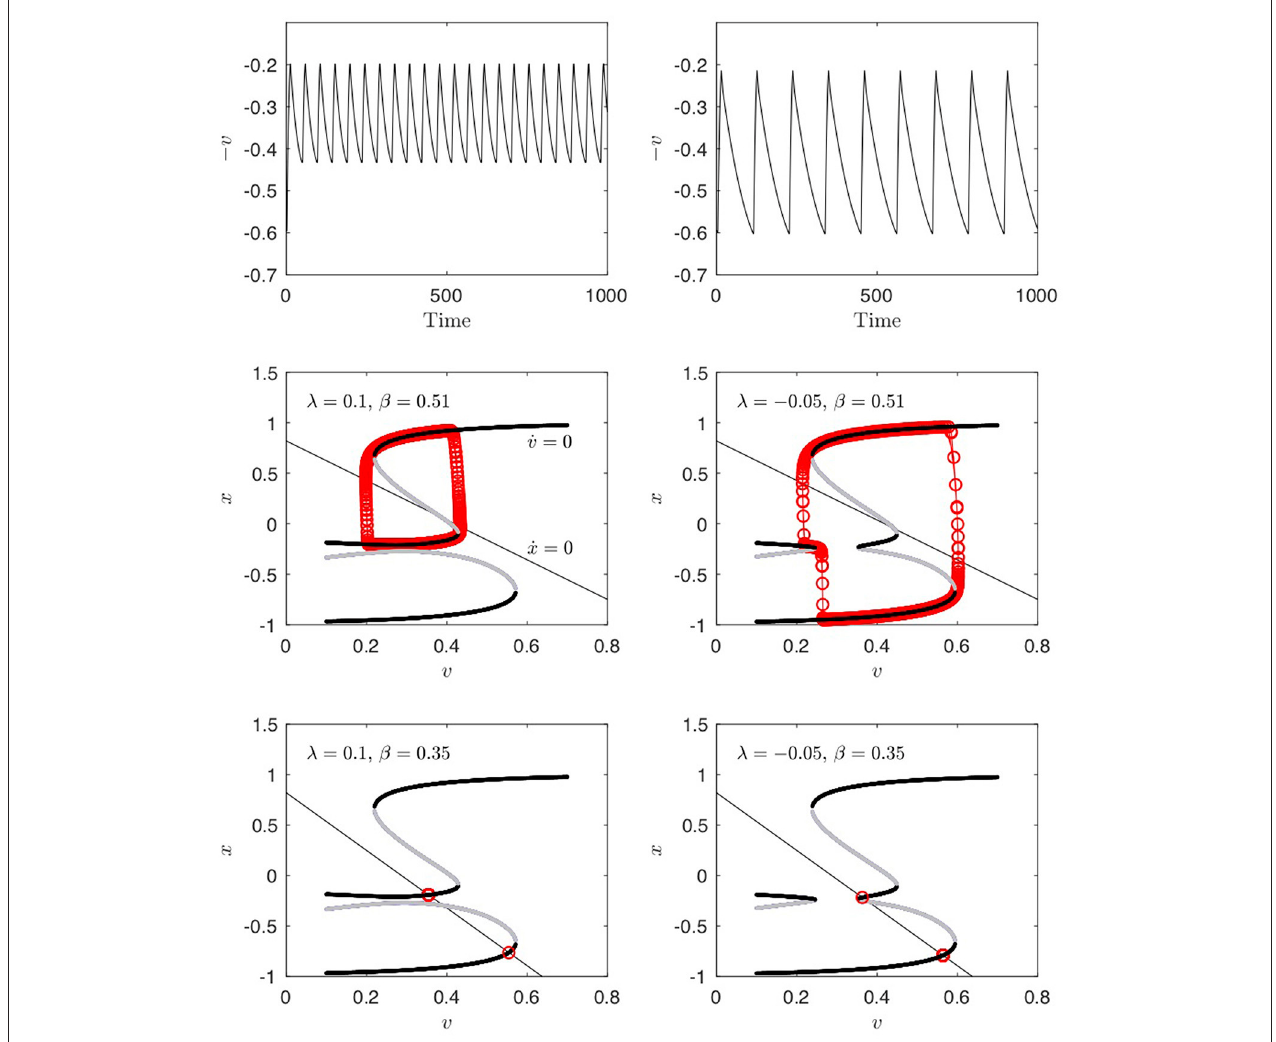
FIGURE 14 | In the autonomous case of no external forcing ( I ( t ) = 0, λ = constant), the system (7) shows internal oscillations both before ( λ > 0) and after ( λ < 0) the transcritical bifurcation at MPT . The period of the internal oscillation is longer than the period of the forcing (41 kyr): Right top panel shows an internal oscillation of 46 kyr for λ = 0.01, while the left top panel shows an internal oscillation of 110 kyr for λ = − 0.05. The middle panels shows the bifurcation diagrams similar to Figure 11 . The straight line is the x -nullcline, which crosses the v -nullcline at an unstable branch, thus the fixed point is unstable. By changing β (see Appendix), the x -nullcline moves such that it crosses at a stable branch and the fixed point becomes stable and the limit cycle disappears. This is shown in the bottom panels, with the (multiple) fixed points marked in red.